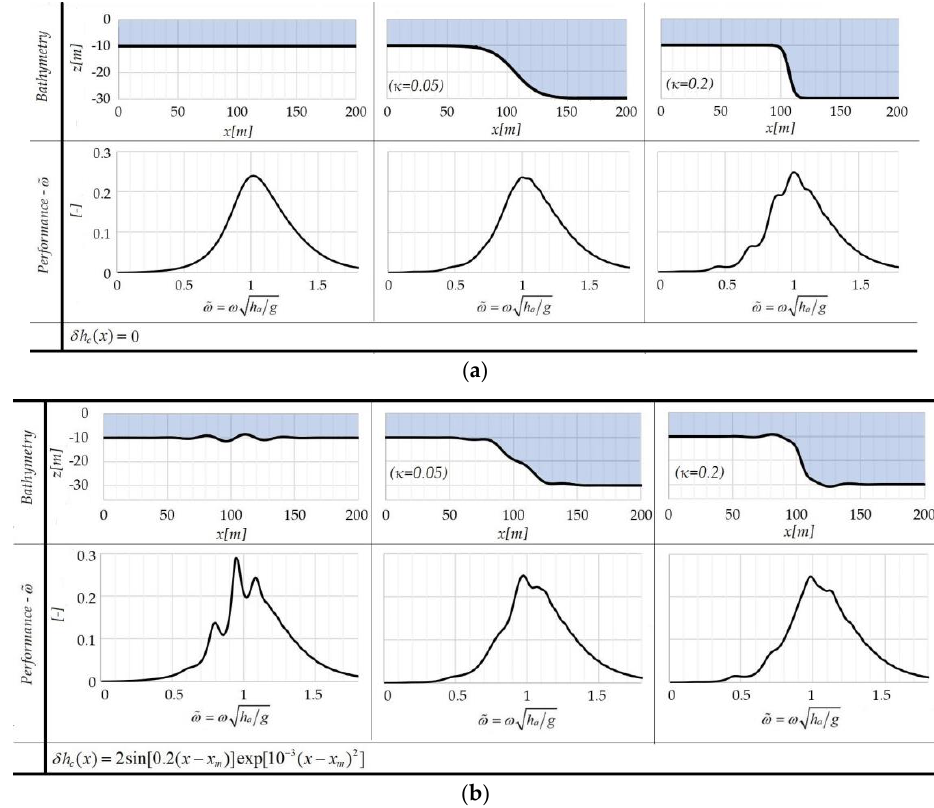
Figure 9. ( a ). U-OWC performance curves in variable bathymetry ( Parameters : h a = 10 m , h b = 30 m